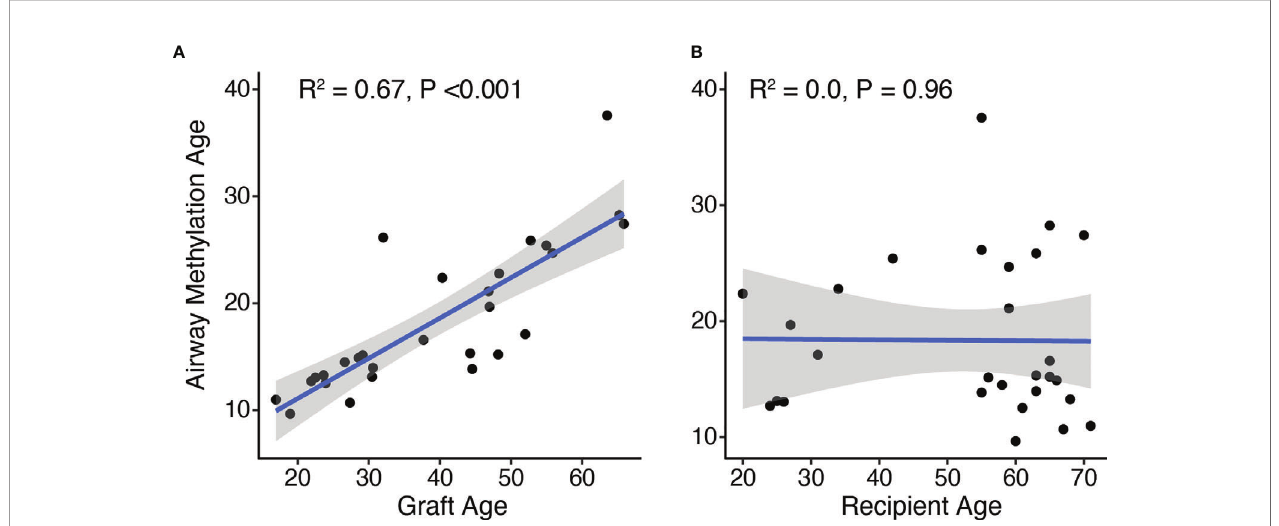
FIGURE 1 | DNA methylation age correlates with allograft donor but not recipient ages. The age predicted by DNA methylation pattern was compared to the age of the graft (A) or recipients (B) based on time between airway brush and donor or recipient birthdate, respectively. R 2 and p-values for the 28 subjects were determined by Pierson ’ s product moment correlation. By linear regression, airway methylation age increased by 0.38 (95% CI 0.27 – 0.48) per year of allograft